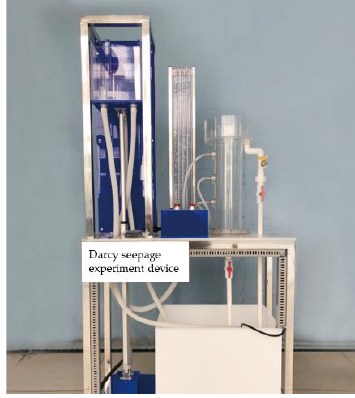
Figure 5. Schematic diagram of Darcy seepage tester.